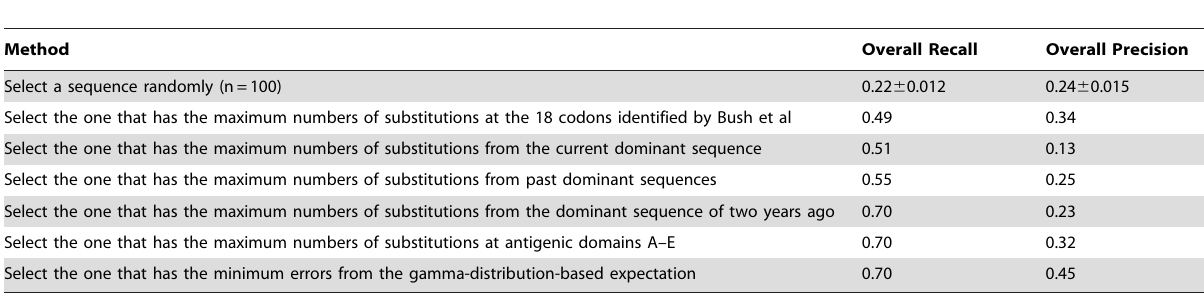
Table 2. Comparison of overall recall and precision with other methods.